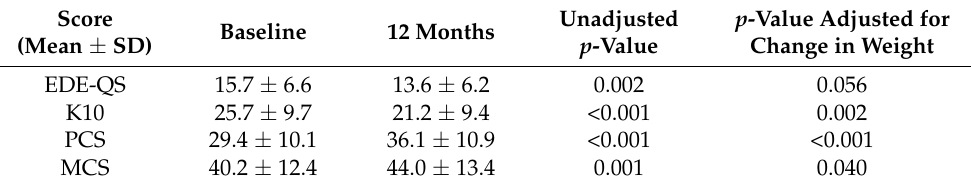
Table 2. Mean EDE-QS, K10, PCS, and MCS scores at baseline and 12 months.